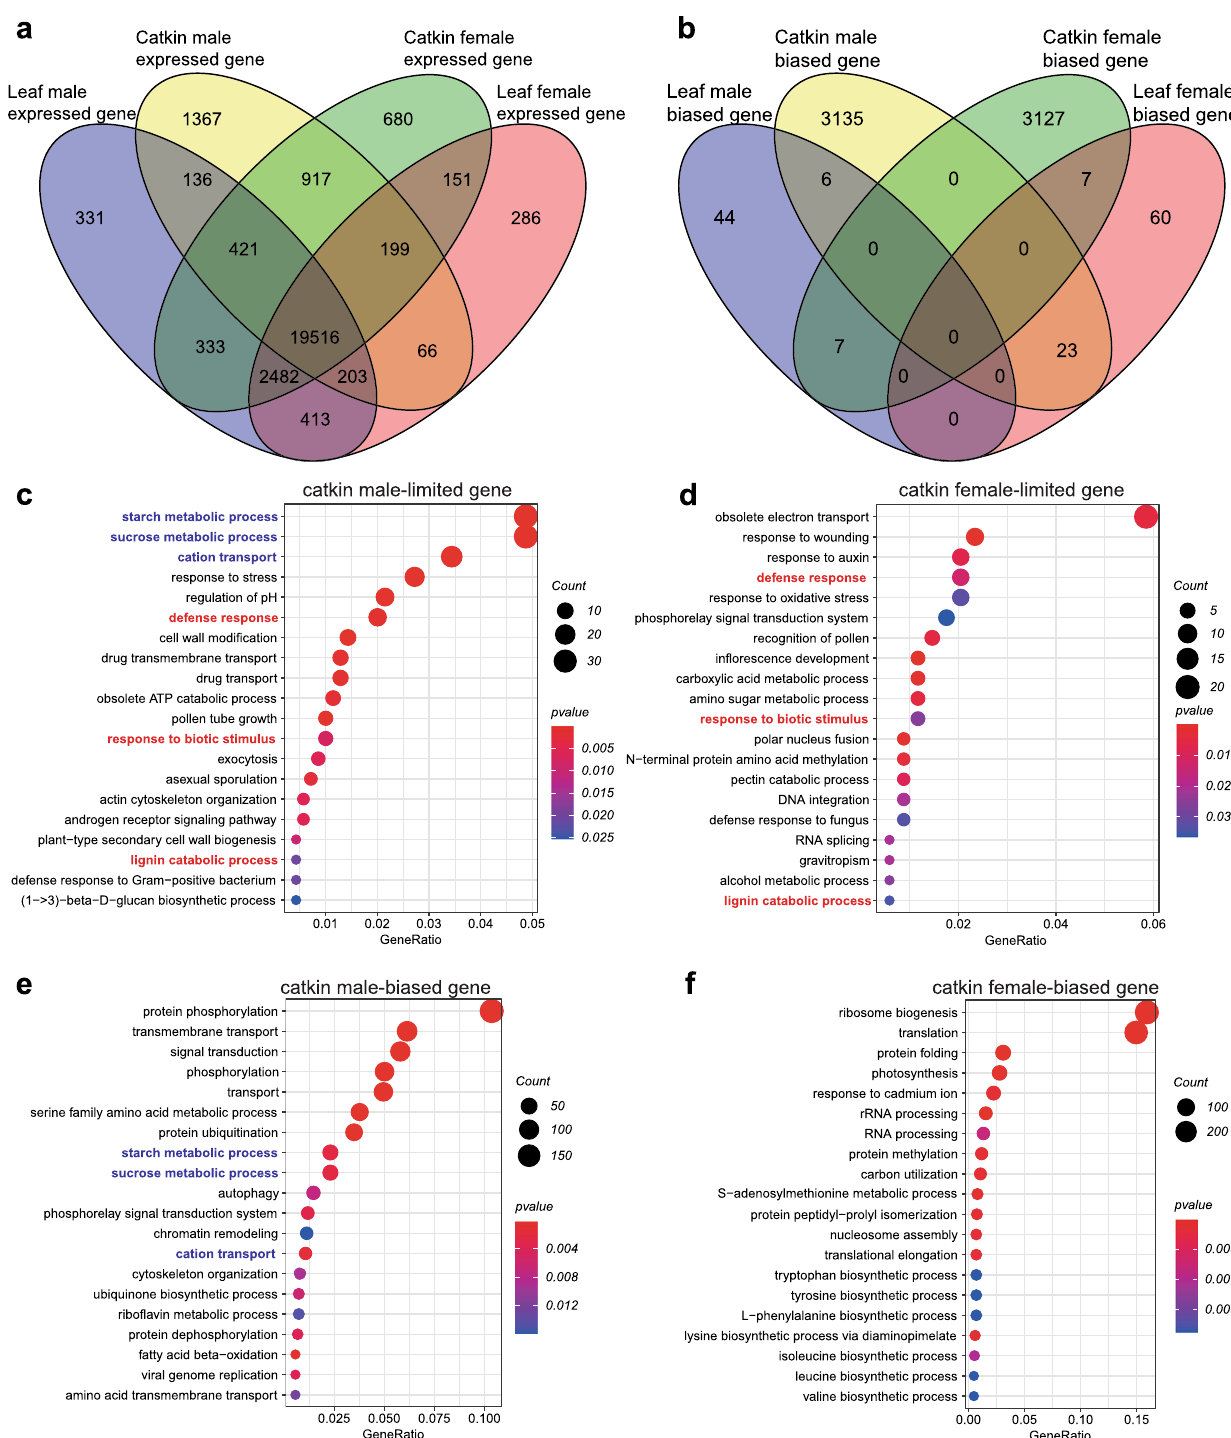
Fig. 6 Genes differentially expressed by sex across the genome of P. euphratica . a Venn diagram showing the comparison of genes expressed in catkins and leaves from P. euphratica male or female trees. b Venn diagram showing the comparison of sex-biased expressed genes in P. euphratica catkins and leaves. Top 20 enriched biological processes of catkin male-limited genes ( c ) and female-limited genes ( d ). Top 20 enriched biological processes of catkin male-biased genes ( e ) and female-biased genes ( f ). For c – f , the shared terms enriched for female- and male-limited genes are indicated in red, while the shared terms enriched for male-limited genes and -biased genes in catkin are shown in and sucrose metabolism ( P = 4 × 10 – 2 , 5/246) were enriched in the 286 female-limited genes (Supplementary Data 26). Although mentary Data 27). the enrichment of SLGs shared between catkins and leaves may indicate common sexual dimorphism in these two tissues in P.